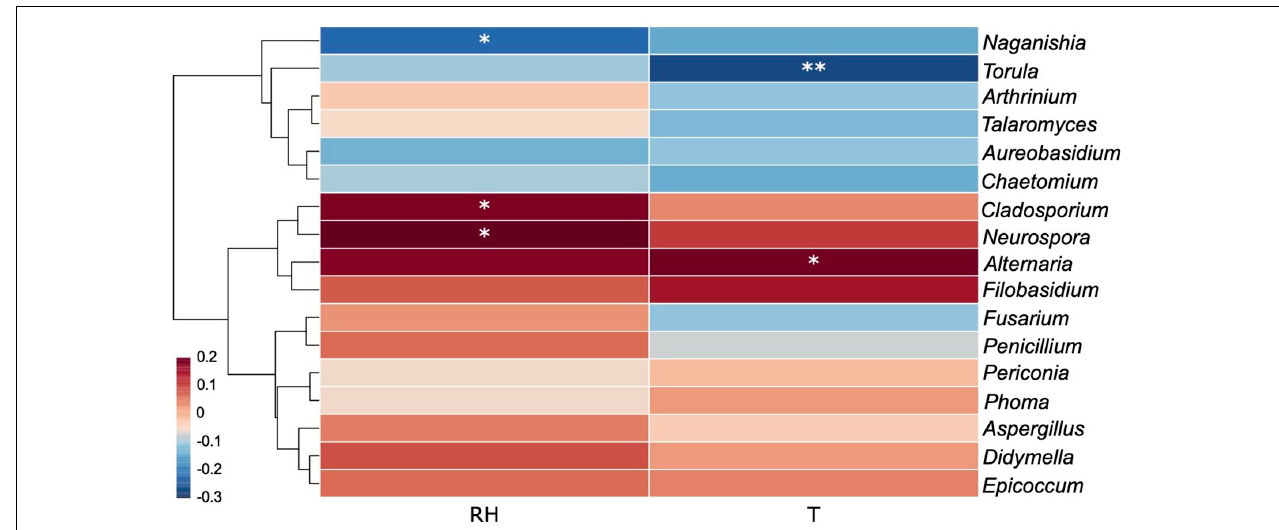
FIGURE 12 | Correlation heat map of the dominant fungal genera (with abundance > 5) and environmental factors. Different colors infer to Spearman’s rank correlation coefficients ( r ). RH and T refer to “relative humidity” and “temperature.” p is indicated as: ∗ p < 0.05, ∗∗ p <